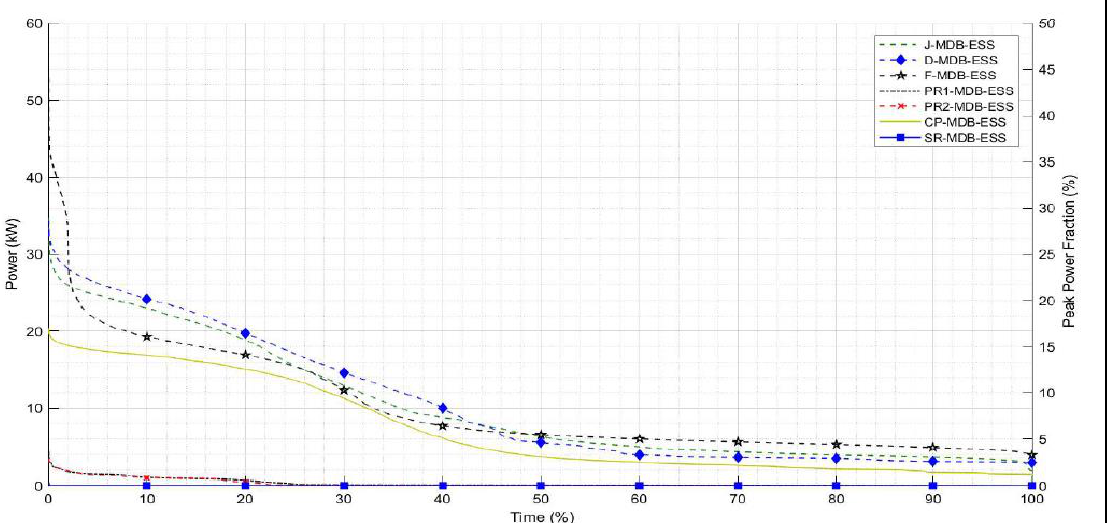
Figure 6. Segregation of essential loads .